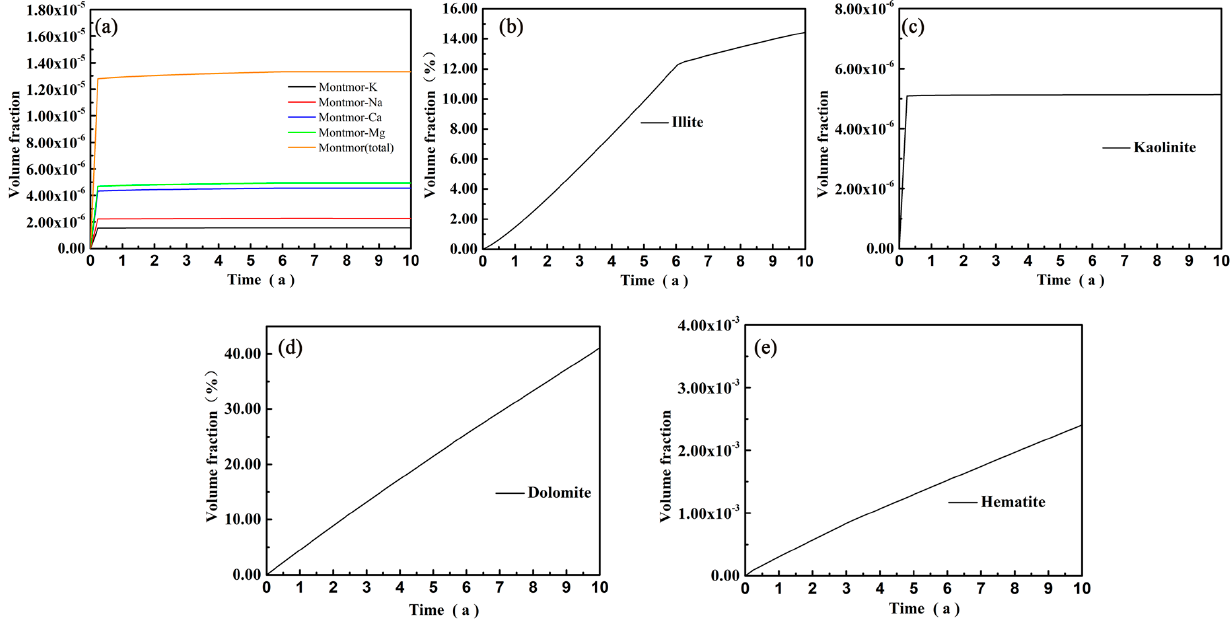
Figure 7. Precipitation of secondary minerals at the injection point. ( a )—Montmorillonite; ( b )—Illite; ( c )—Kaolinite; ( d )—Dolomite; ( e )—Hematite.